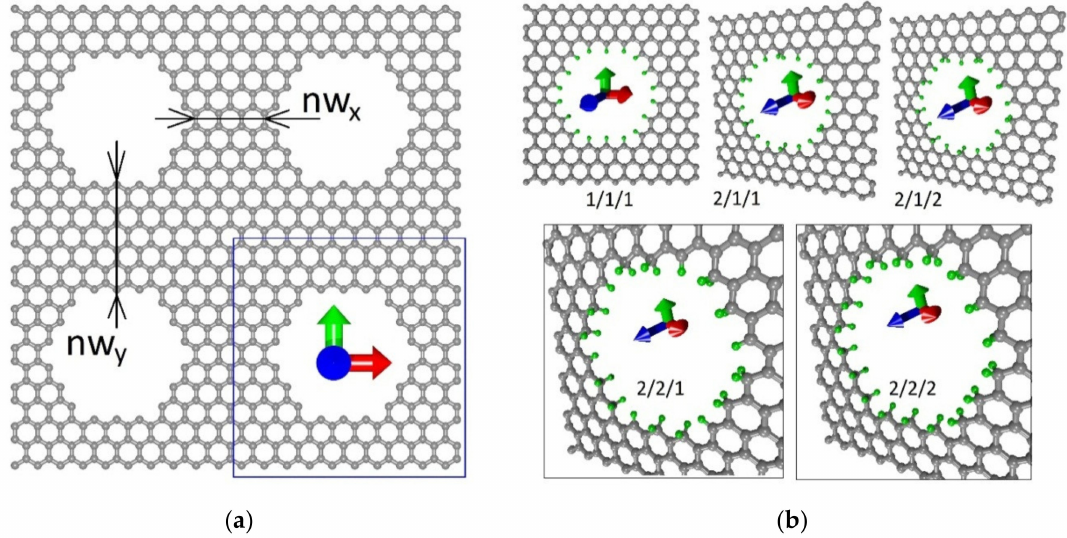
Figure 1. Atomistic models: ( a ) GNM, ( b ) GNM super-cells with di ff erent types of hydrogenation of the nanohole edges. The super-cell of GNM is highlighted in the blue box. Hydrogen atoms are marked in